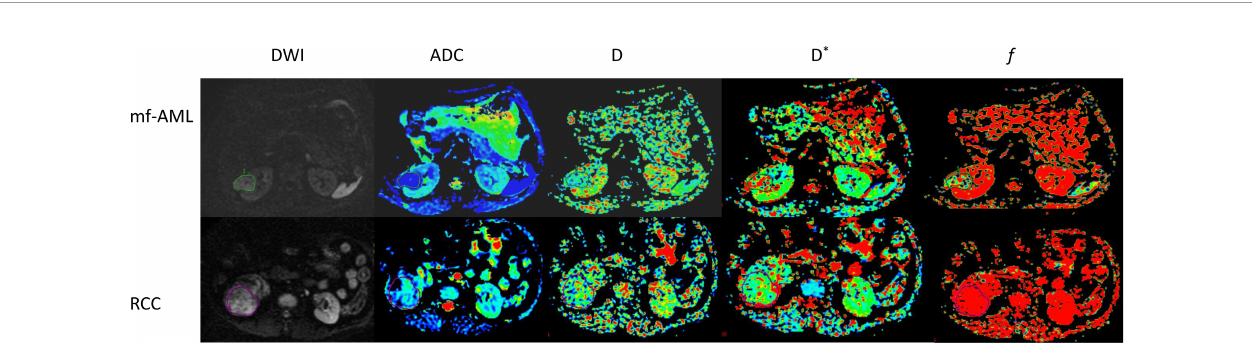
FIGURE 1 | IVIM-DWI images of mf-AML and RCC. The tumors were displayed in DWI images. The D, D*, and f maps were obtained from IVIM of mf-AML in the top low and RCC in the bottow row, respectively. Outlines indicate the tumor